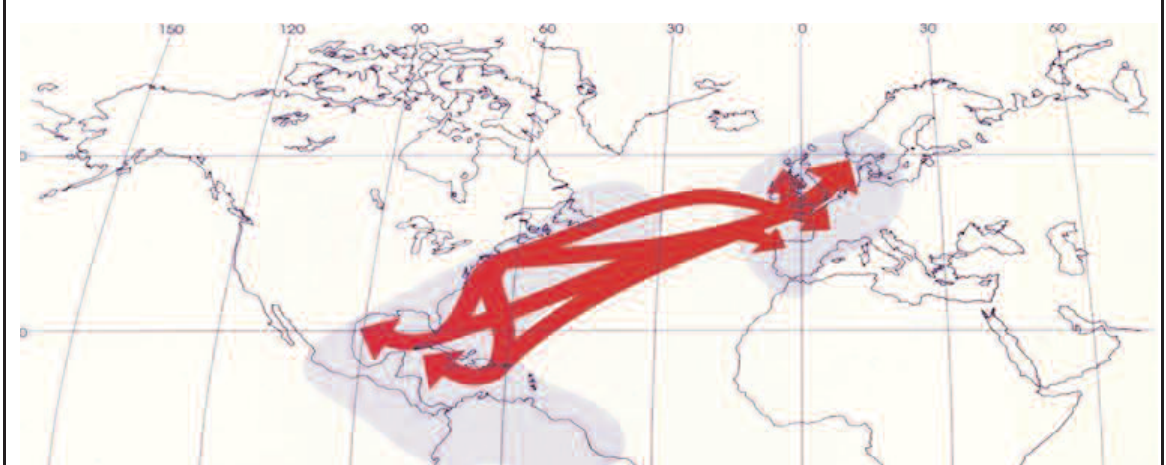
Figure 1. Trade Map of Scandia,